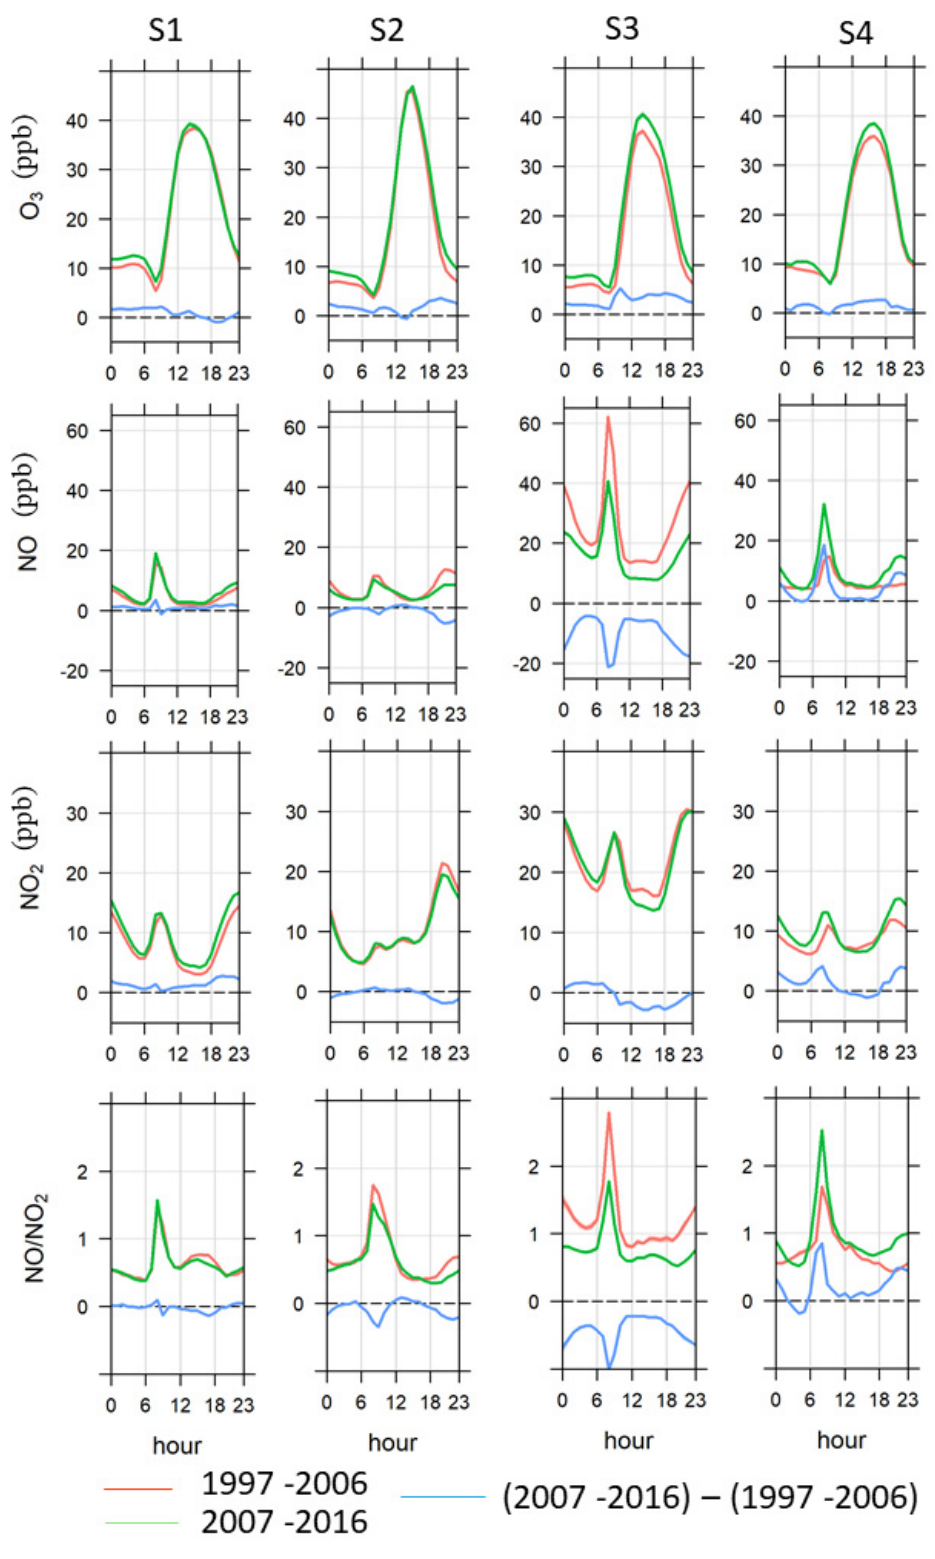
Figure 7. Composite of diurnal plots for O 3 , NO, NO 2 , and NO/NO 2 .